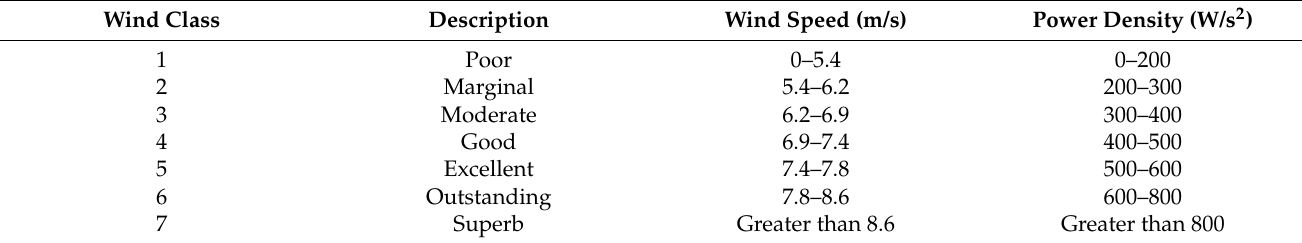
Table 4. Wind Potential of Pakistan [84].